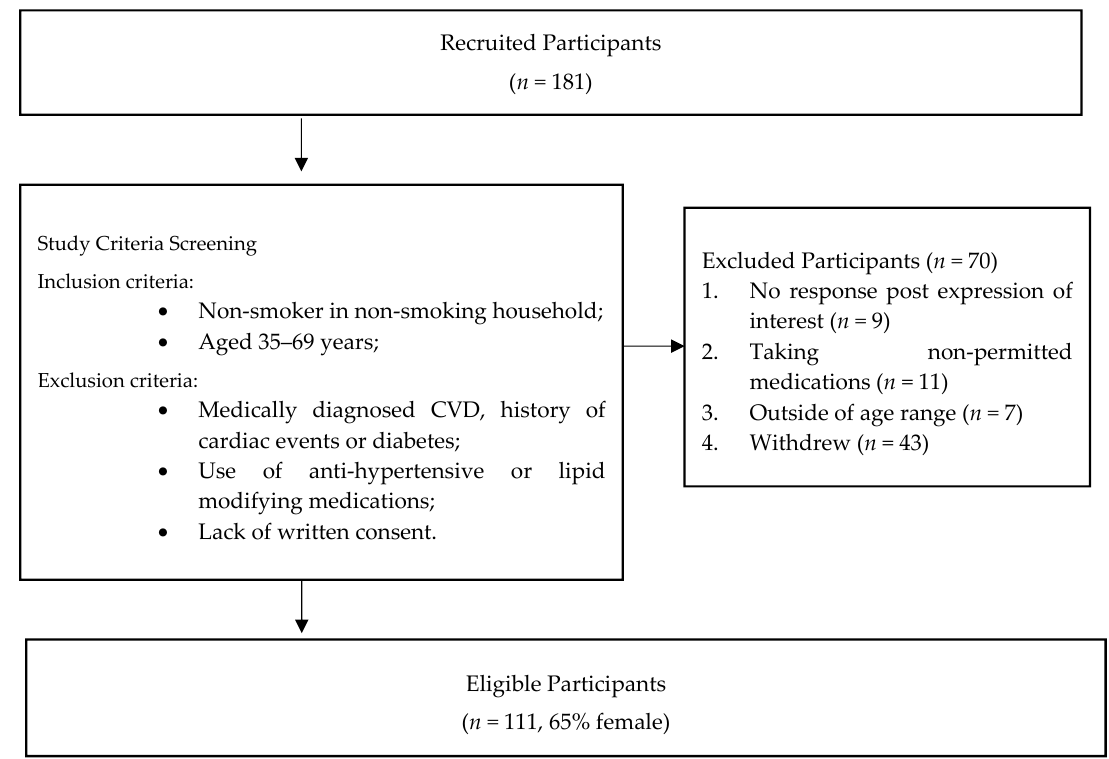
Figure 1. Study population recruitment process.